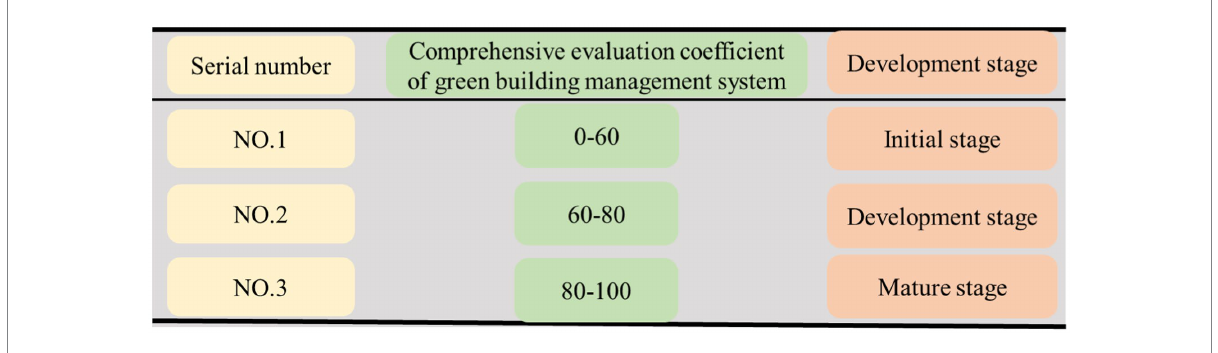
FIGURE 5 Evaluation coefficient of green building management